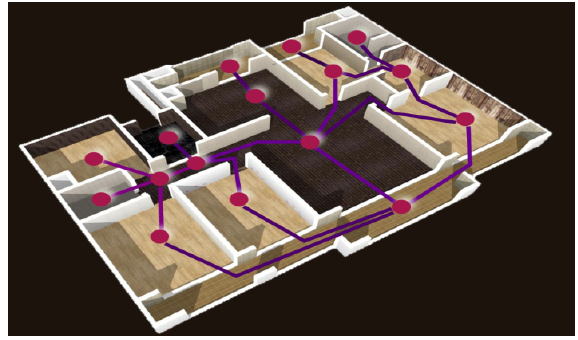
Figure 10. Model of IndoorGML schema. Figure courtesy of OGC.